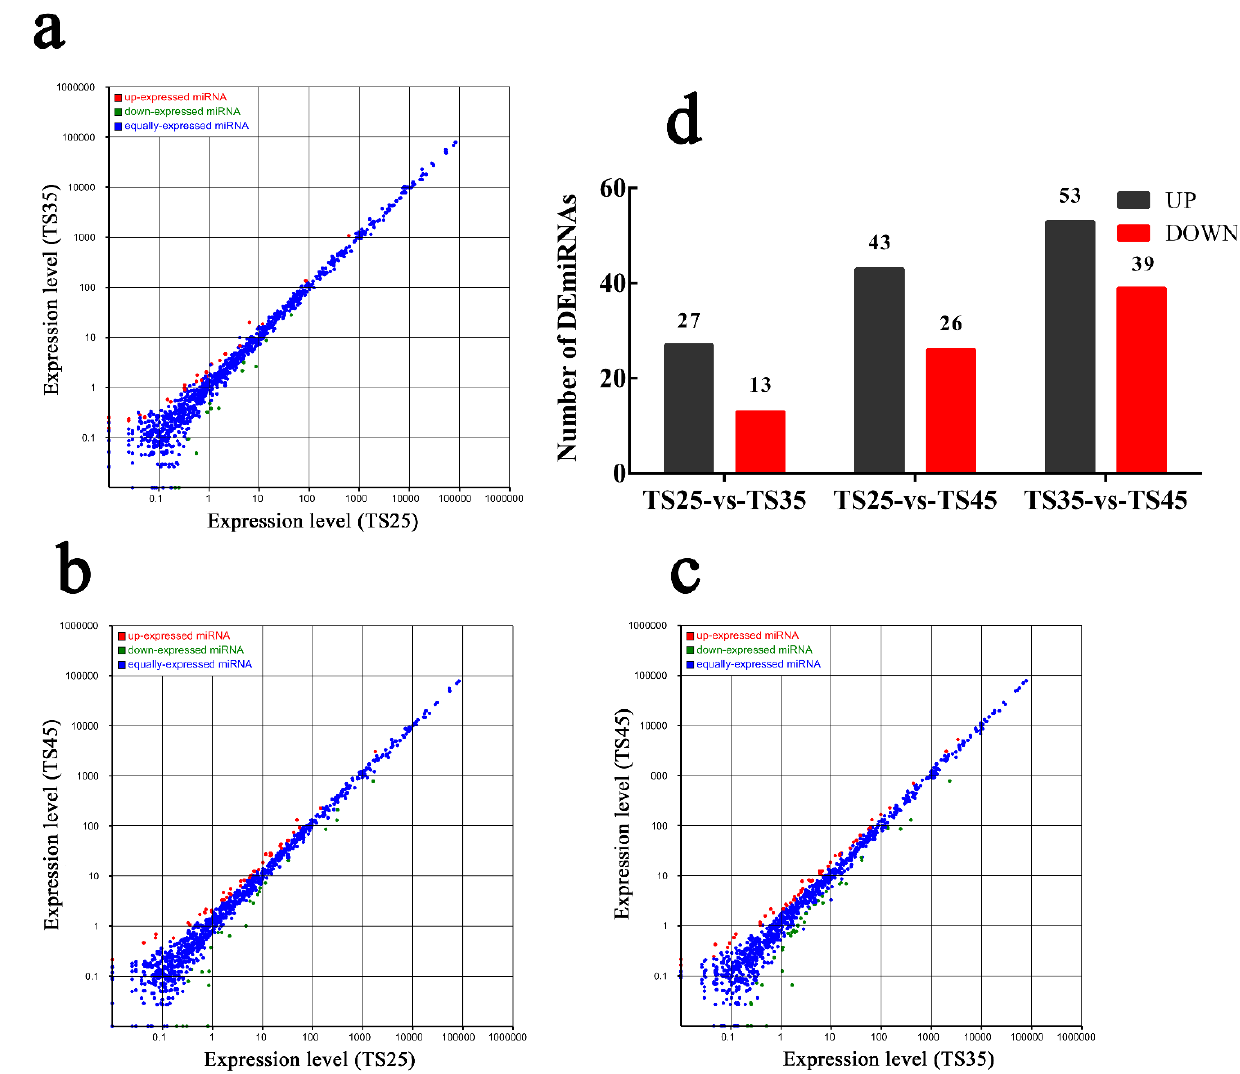
Figure 3. Results of miRNA-Seq in heart tissue of Tibetan sheep at different altitudes. The scatter plot shows that DEmiRNASs were up-regulated and down-regulated between groups. The abscissa is the expression level of the control group, and the ordinate is the expression level of the experimental group. Red indicates up-regulated miRNA, green indicates down-regulated miRNA, and blue indicates co expressed miRNA. ( a ) Scatter plot of TS35 DEmiRNAs relative to TS25. ( b ) Scatter plot of TS45 DEmiRNAs relative to TS25. ( c ) Scatter plot of TS45 DEmiRNAs relative to TS35. ( d ) Statistical of DEmiRNAs in three group. ( TS25 ) 2500 m altitude Tibetan sheep. ( TS35 ) 3500 m altitude Tibetan sheep. ( TS45 ) 4500 m altitude Tibetan sheep.